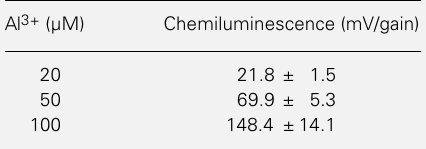
Table 2 - Effect of different concentrations of alu- minum on chemiluminescence intensity. Platelets were incubated at 37 o C, Al 3+ solutions were added and chemiluminescence intensity (mV/gain) was recorded for 5 min. Data are re- ported as mean – SEM of 10 independent deter- minations. Al 3+